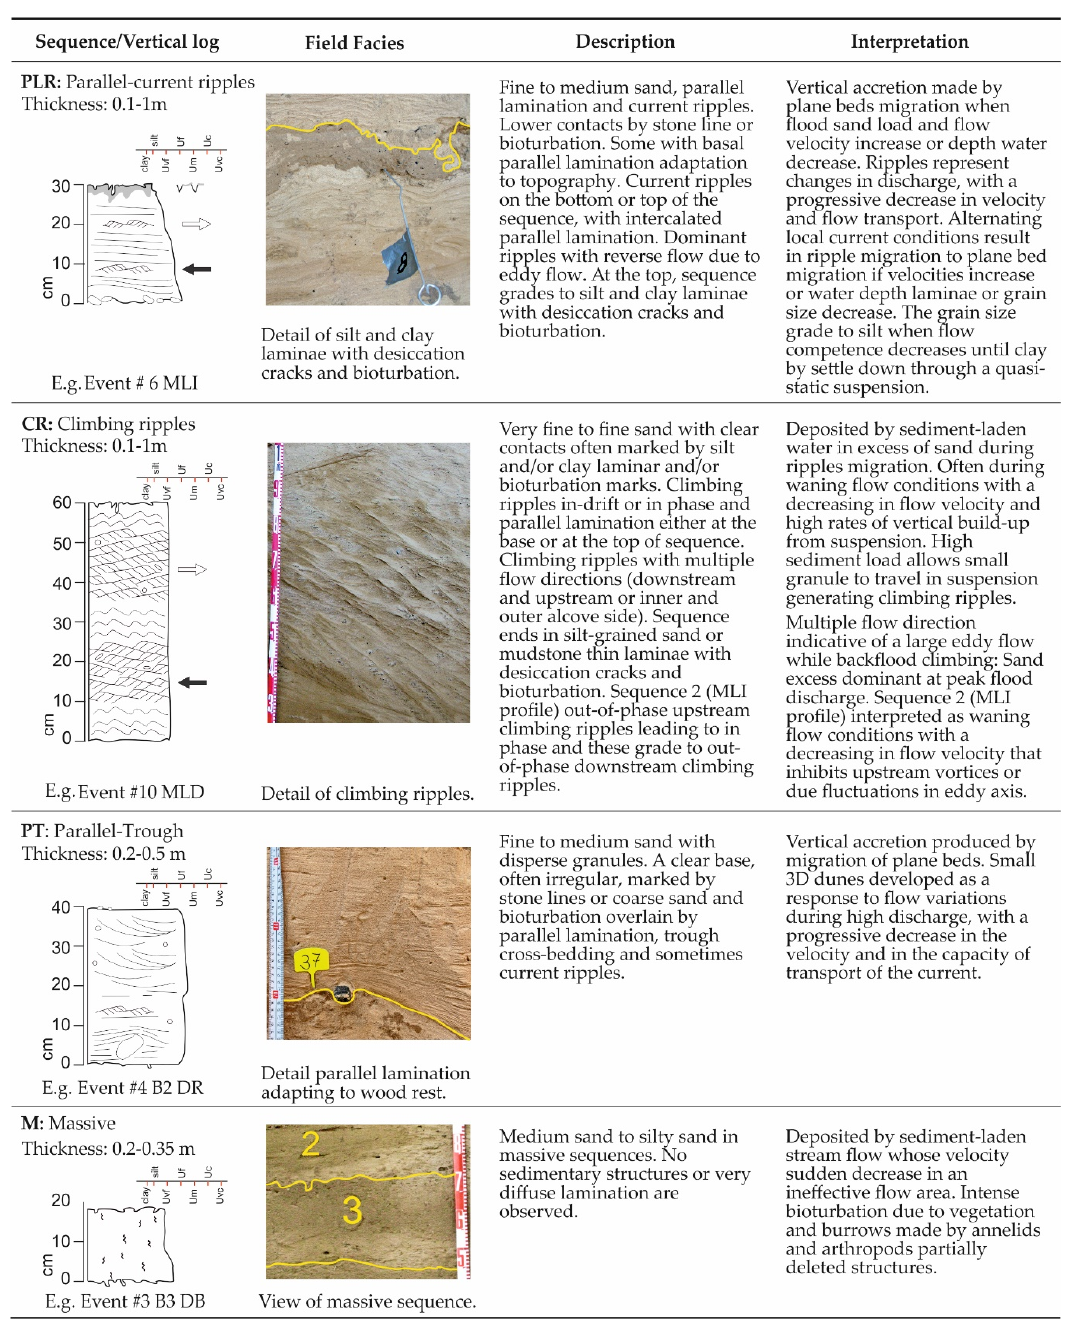
Figure 3. Representative sedimentary sequences in the slackwater flood deposits of the Montlleó River, and interpretation of the sedimentary environment.